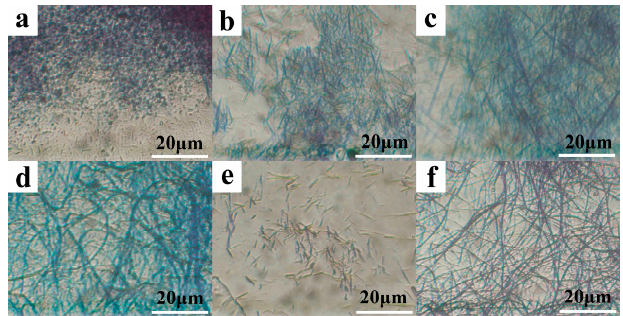
Figure 6. Optical microscope images of PBI-1 aggregates assembled in various organic acids. ( a ) r = 10,000:1 oxalic acid, ( b ) r = 5000:1 malonic acid, ( c ) r = 10,000:1 citric acid, ( d ) r = 10,000:1 formic acid, ( e ) r = 10,000:1 glutaric acid and ( f ) r = 5000:1 acetic acid.